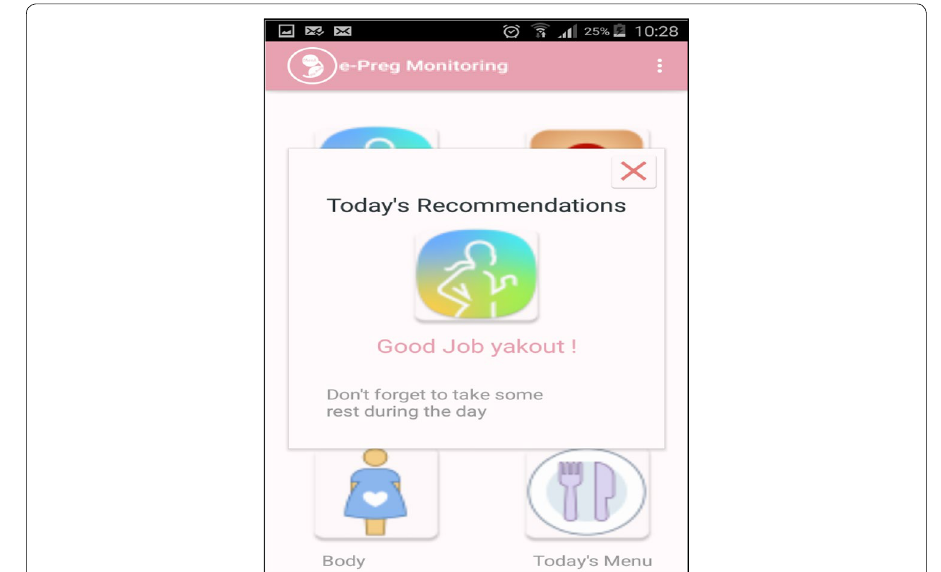
Fig. 10 Screenshot of activity’s recommendations